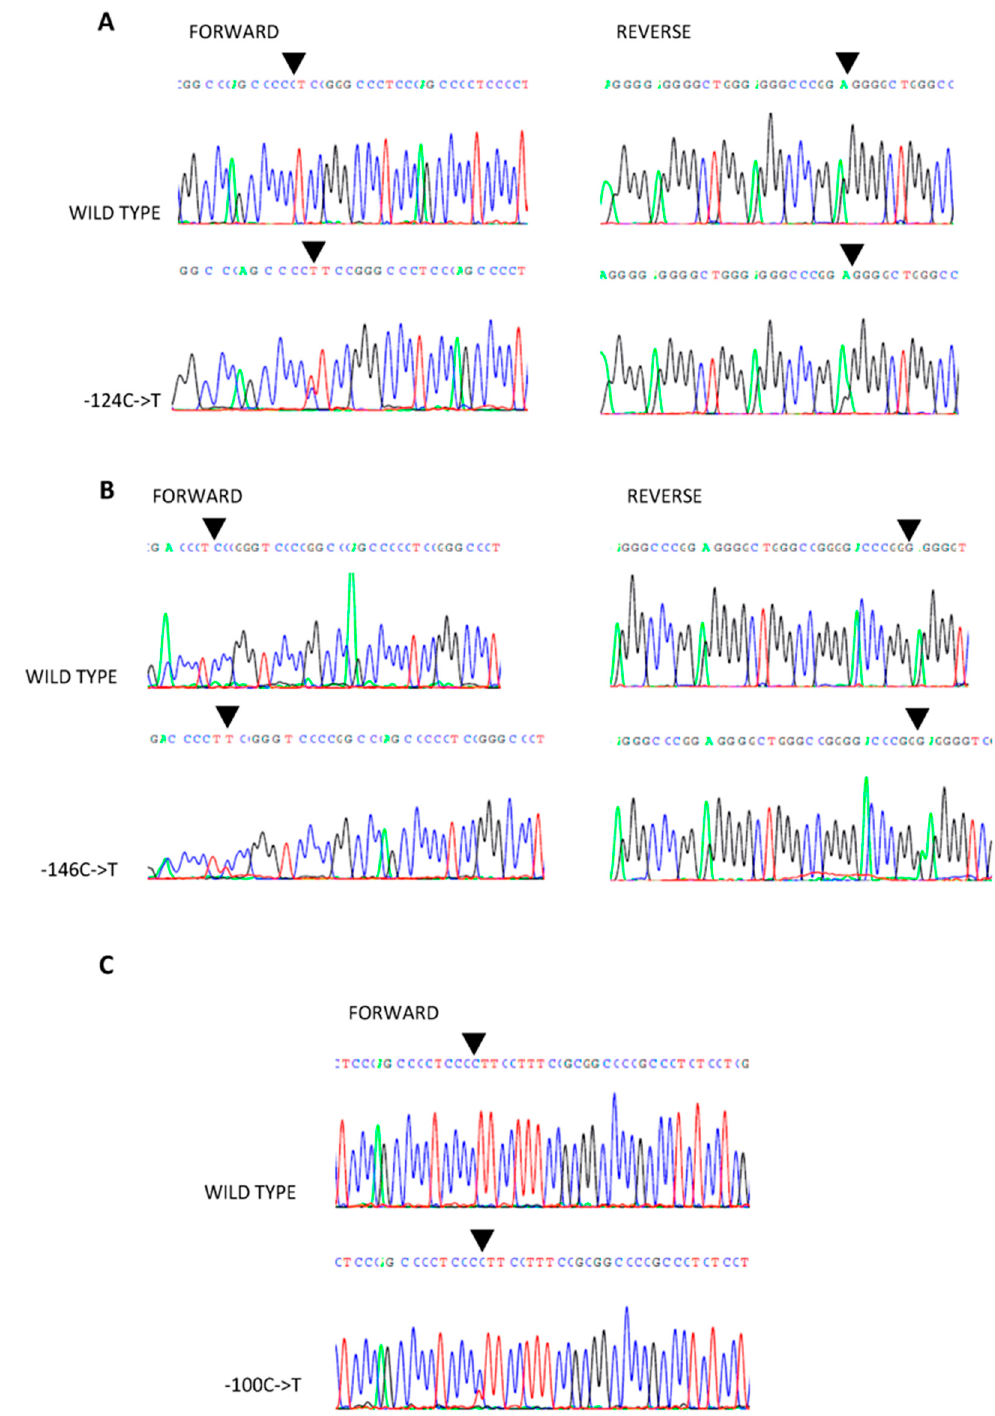
Figure 1. Known TERT promoter (TERT p) alterations detected in the analyzed papillary thyroid carcinoma (PTC) cohort. ( A ) Mutation − 124 C->T (C228T); ( B ) mutation − 146 C->T (C250T); ( C ) alteration − 100 C->T (rs2735943). The black triangles point to the nucleotide positions of the nucleotide changes.